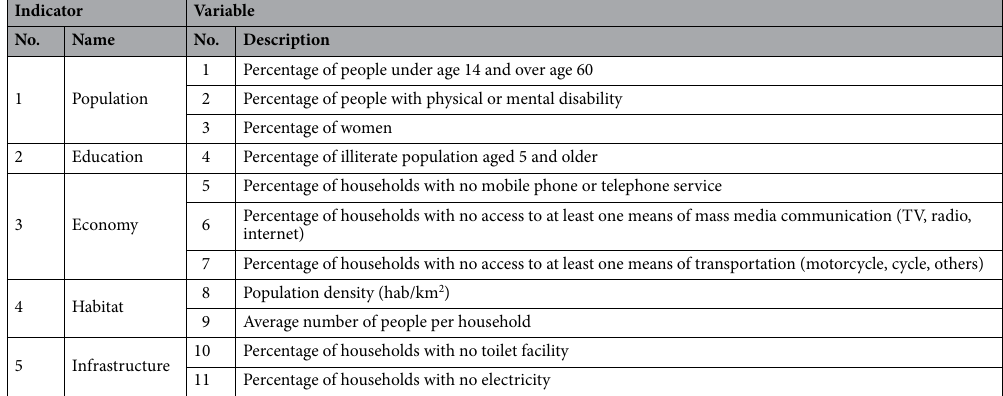
Table 1 provides the list of variables and indicators used to construct the SoVI for Kathmandu Valley. The Population indicator is composed of three variables. Young children (under 14 years old), older adults (over 60 years old), and individuals with physical or mental disabilities are commonly regarded as the most vulnerable members of the population. In addition, women are seen as more vulnerable than men due to their sector-specific employment, lower salaries and family care responsibilities 22 . The Education indicator is composed of a single variable. Education leads to a better-informed population and a higher level of preparedness for disasters. In contrast, illiterate populations have more difficulties understanding warning information and accessing recov- ery information 22 . The Economy indicator is composed of three variables. More wealth increases possibilities to absorb and recover from losses, through insurance, social safety nets, and government assistance 22 . As the census does not provide information on household income or consumption, we selected access to mobile/telephone services, mass media communication (TV, radio, internet) and means of transportation (motorcycle, cycle, others) as proxies for wealth. The lack of access to these services/assets indicates lower economic well-being. The Habitat indicator is composed of two variables. Urban areas with high population density can be more chal- lenging to evacuate after a disaster. Also, households with large families often have limited resources and must balance work with family responsibilities 22 . Finally, the Infrastructure indicator is composed of two variables. Access to critical facilities can enhance emergency response after a disaster. In contrast, a lack of access to basic services, such as sanitary facilities and electricity, may compromise health and safety during disaster recovery. Two previous applications of the SoVI in Nepal 97,99 and one application in Nablus (Palestine) 23 inspired our selection of variables and indicators. Note that both previous SoVI studies of Nepal differ significantly to our work in terms of scale; we conducted a detailed regional assessment (in Kathmandu Valley), whereas Gautam 99 and Aksha et al. 97 examined social vulnerability on a more coarse, national scale. We employed most variables used by Gautam 99 , excluding only two (i.e., percentage of female-headed households with no shared responsibility, population change 2000–2010) that describe similar information to other variables (i.e., percentage of women, population density). We used only a small sub-group of the variables leveraged in the study of Aksha et al. 97 . We excluded some of their variables on house construction materials (e.g., percentage of households without reinforced cement concrete foundation, percentage of population living in houses with low-quality external walls), which are more appropriate for assessing physical vulnerability. We also neglected some social dimensions (e.g., Ethnicity, Migration, Renters), given the more local context of our study, and characterized others (e.g.,